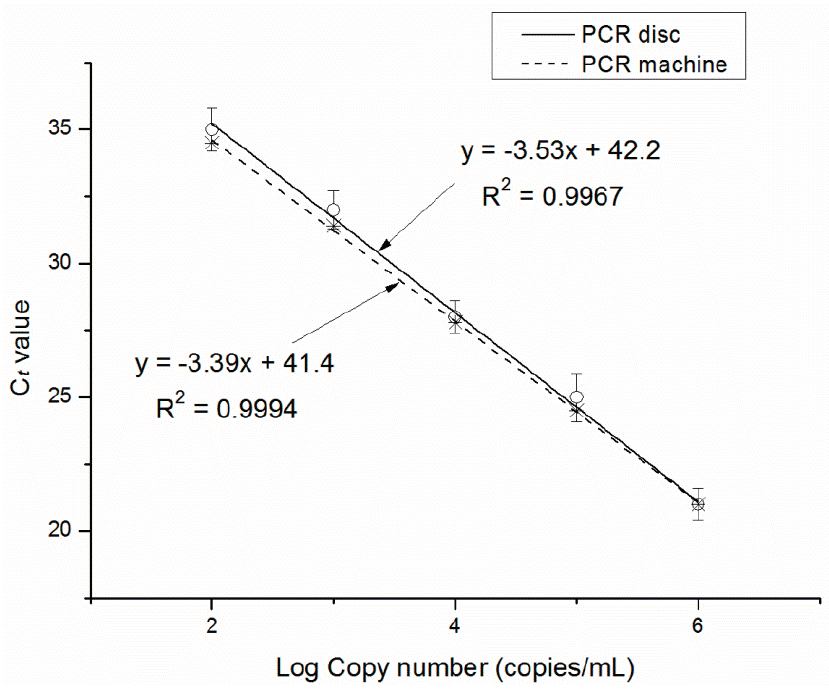
Figure 8. Standard curve for HBV target gene amplification.